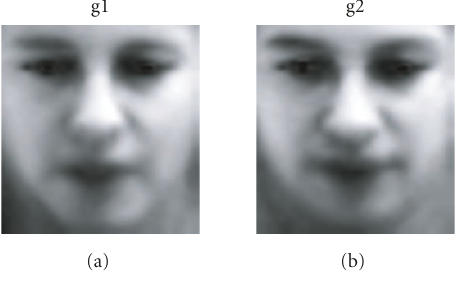
Figure 4: Average face template built using training images defined in the BANCA P protocol for the datasets g1 and g2, respectively.